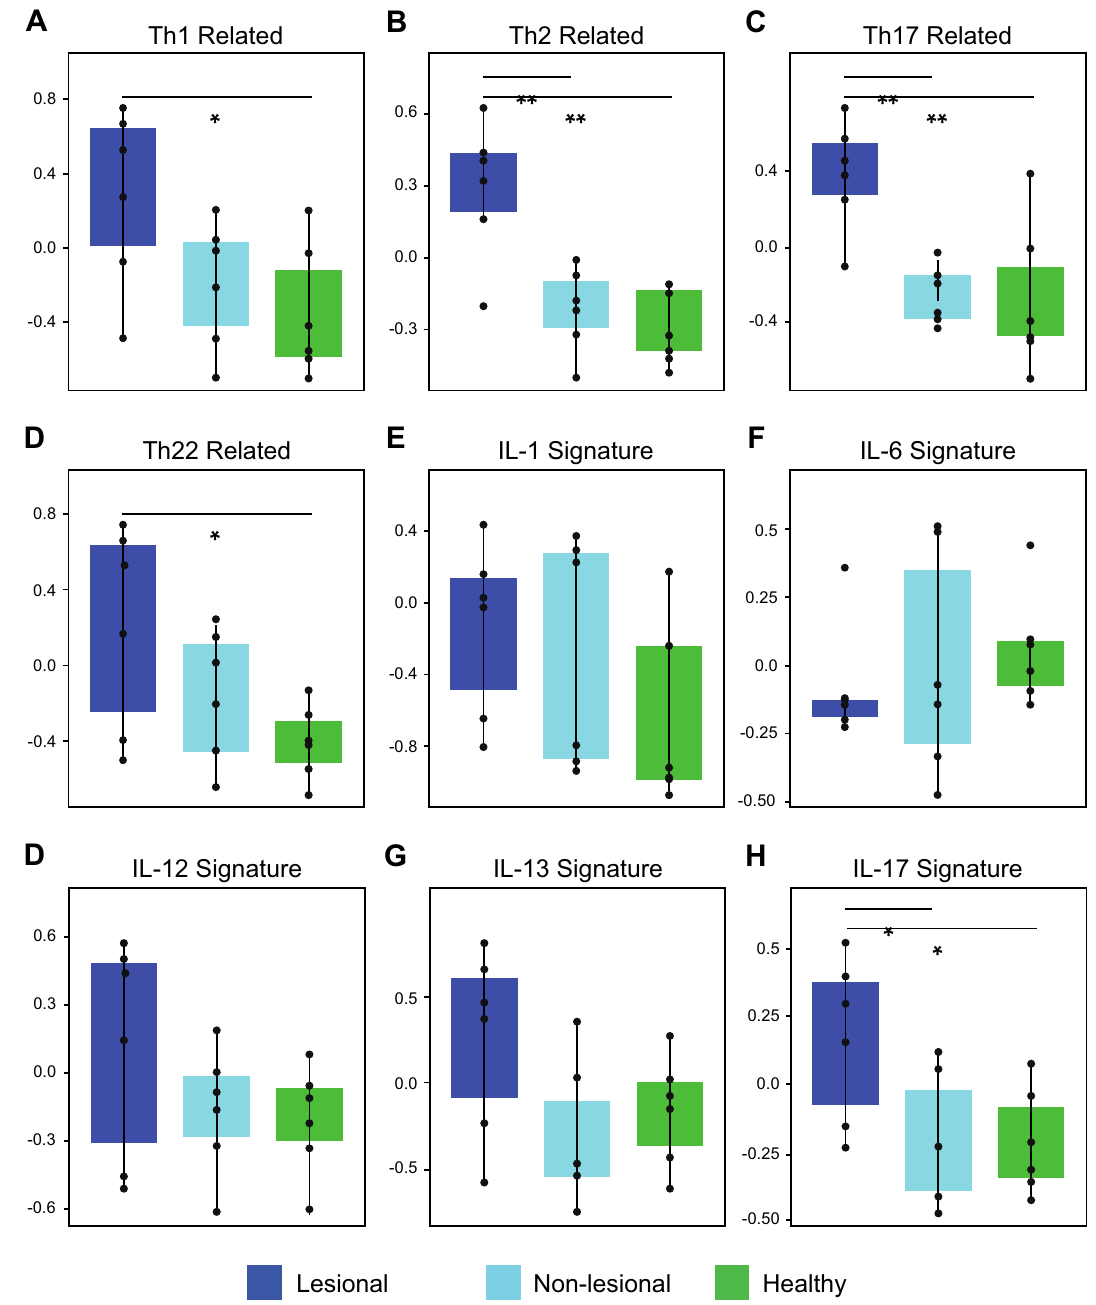
Figure 3. Gene set variation analyses (GSVA) for major immune pathways. *p < 0.05 and **p < 0.01 (n = 6 for each condition). Th1, Th2, Th17, Th22, and IL-17 signatures were upregulated in lesional